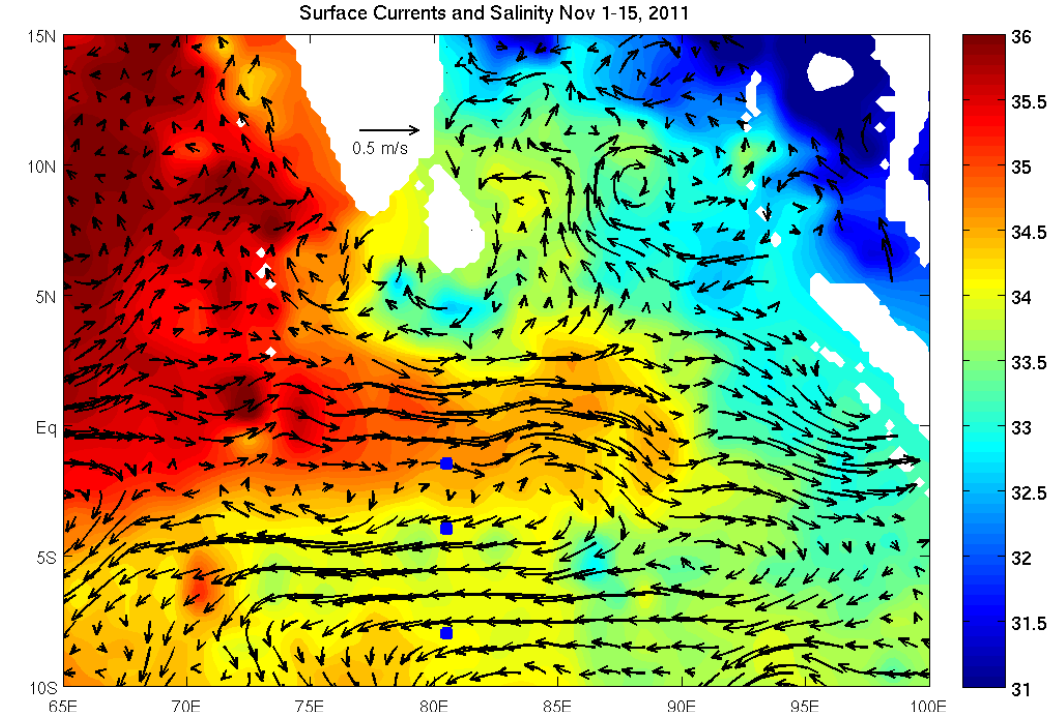
Figure 12. Average SSS (psu) derived from Aquarius measurements and near surface currents (m/s) from OSCAR during 1–15 November. RAMA buoy locations along 80.5°E are indicated by blue closed square marks. SSS data are interpolated to 0.2° × 0.2°